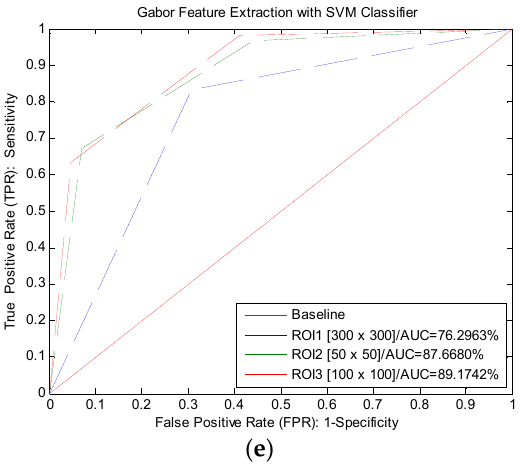
Figure 15. RBF parameters for SVM with feature extraction techniques: ( a ) statistical feature extrac- tion, ( b ) histogram feature extraction, ( c ) GLCM feature extraction, ( d ) BGLAM feature extraction and ( e ) Gabor feature extraction.